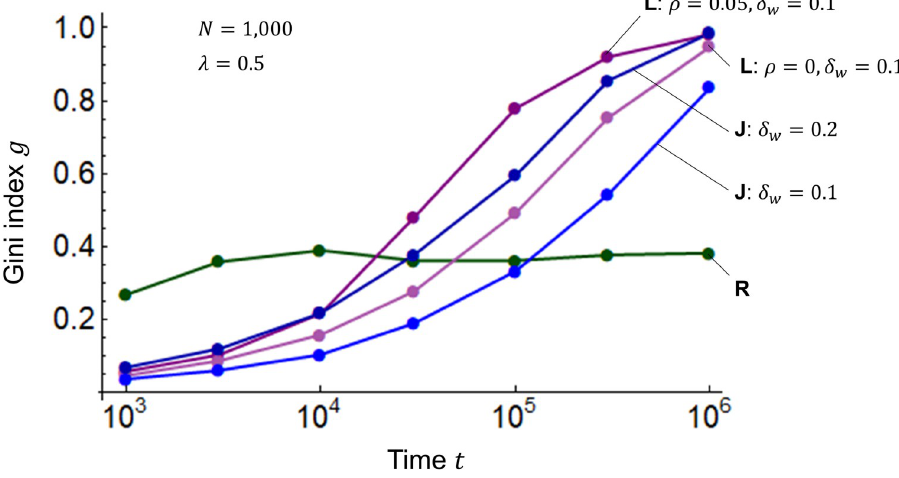
Fig 4. Gini indices for the R, L, and J models. The horizontal axis represents time t , and the vertical axis represents the Gini index g . In all models, the number of agents is N = 1000, the initial values of wealth are m N ), and the savings rate is λ = 0.25. The interest rates of the L model are ρ = 0 and 0.05, and the width of the profit/loss rate δ is δ w = 0.1. The widths of the J model are δ w = 0.1 and